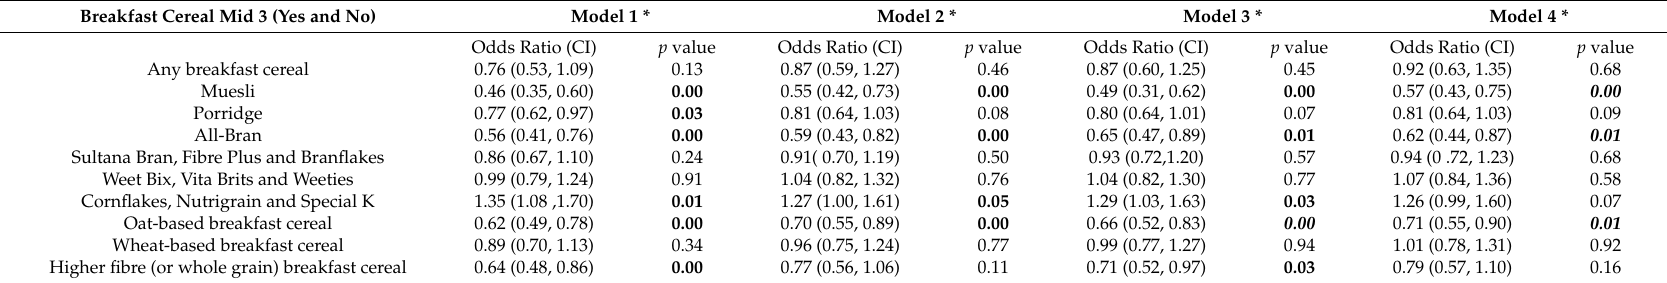
Table 3. Results of the logistic regression models examining the effects of consuming breakfast cereal at Survey 3 on the risk of developing obesity from Surveys 4–7. Breakfast Cereal Mid 3 (Yes and